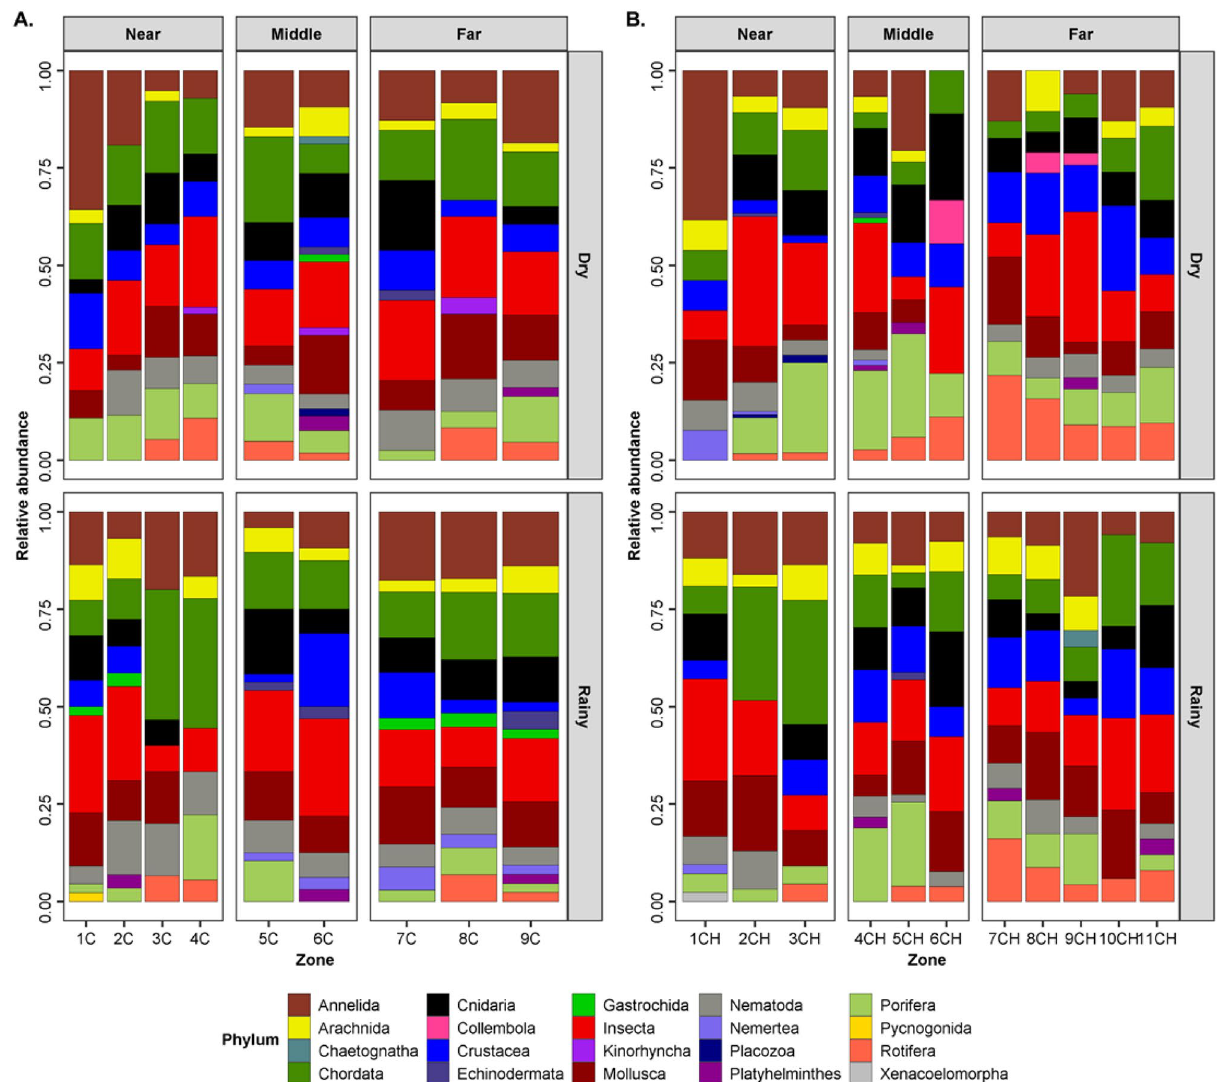
Figure 2. Relative abundance of MOTUs of Metazoan phyla in COI amplicon sequence libraries generated from sediments collected from Chacahua-Pastoria and Corralero-Alotengo lagoon systems throughout seasons, regions and lagoon zones. ( A ) C: Corralero-Alotengo Dry and Rainy seasons. Regions in the lagoon systems (distance to the mouth), N: Near (Zones: 1, 2, 3, 4), M: Middle (Zones: 5, 6) and F: Far (Zones: 7, 8, 9). ( B ) CH: Chacahua-Pastoria Dry and Rainy seasons. Regions in the lagoon systems (distance to the mouth), N: Near (Zones: 1, 2, 3), M: Middle (Zones: 4, 5, 6) and F: Far (Zones: 7, 8, 9, 10,